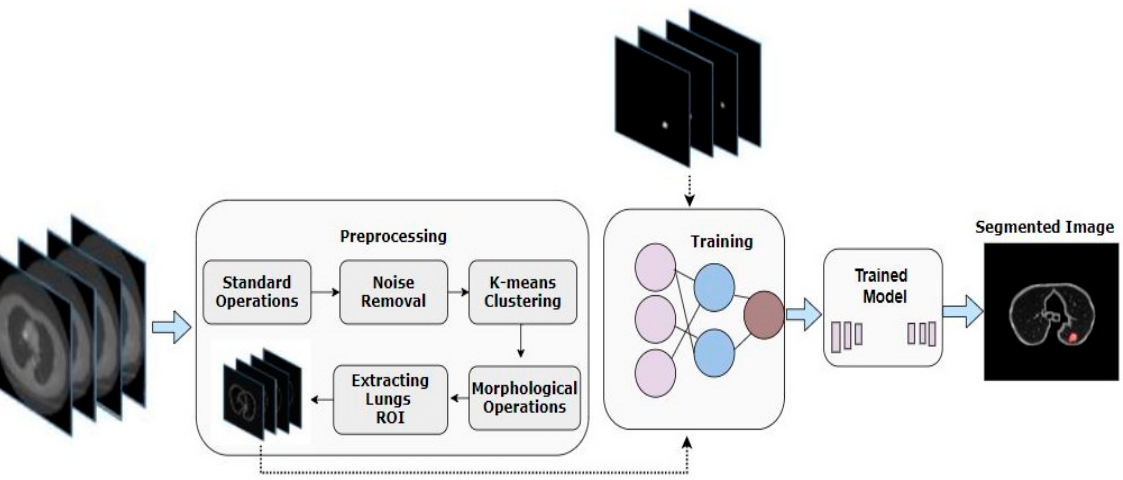
Figure 2. A framework of the proposed method .